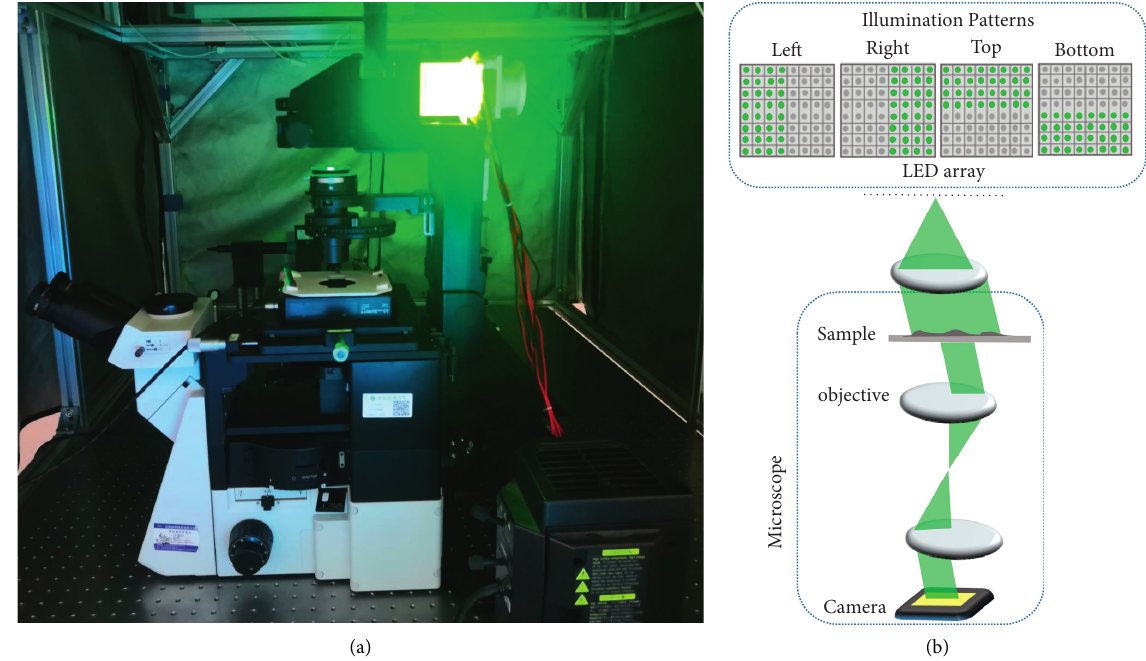
Figure 2: Microscopic imaging device and method. (a) A microscope with a coded LED array for illumination. (b) Imaging from time- shared oblique illumination.